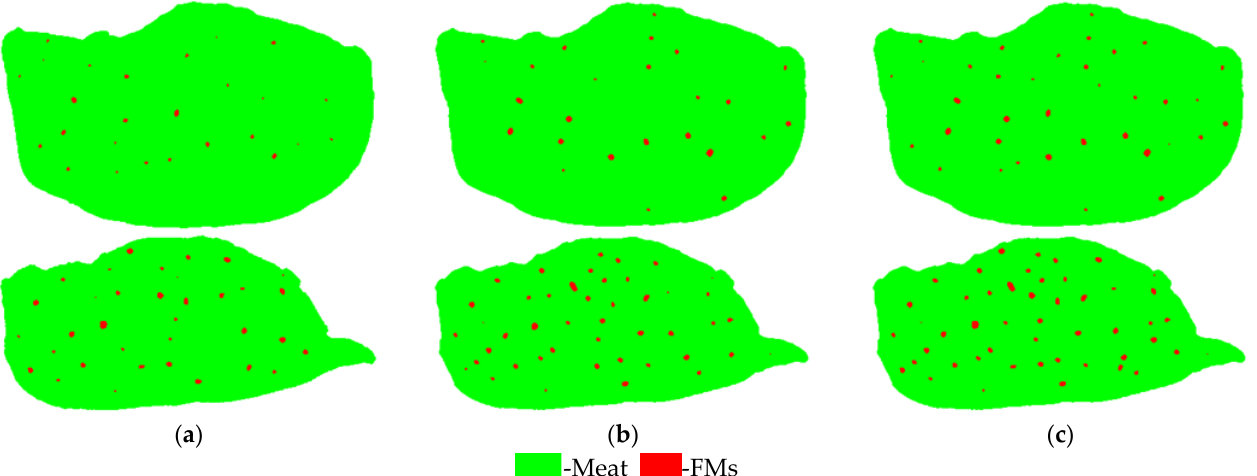
Figure 8. Classification images with ( a ) VNIR model only, ( b ) SWIR model only ( c ) developed fusion algorithm on the test set: Fusion + VNIR + SWIR. Green color represents chicken meat and red color represents